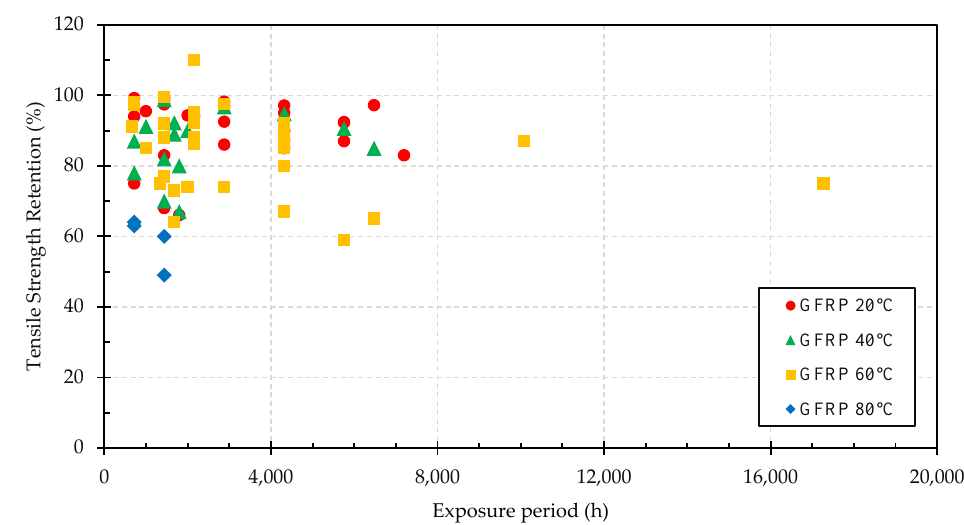
Figure 4. GFRP bars immerse in alkaline solution from available literature [14,55,57,58,83 – 85].